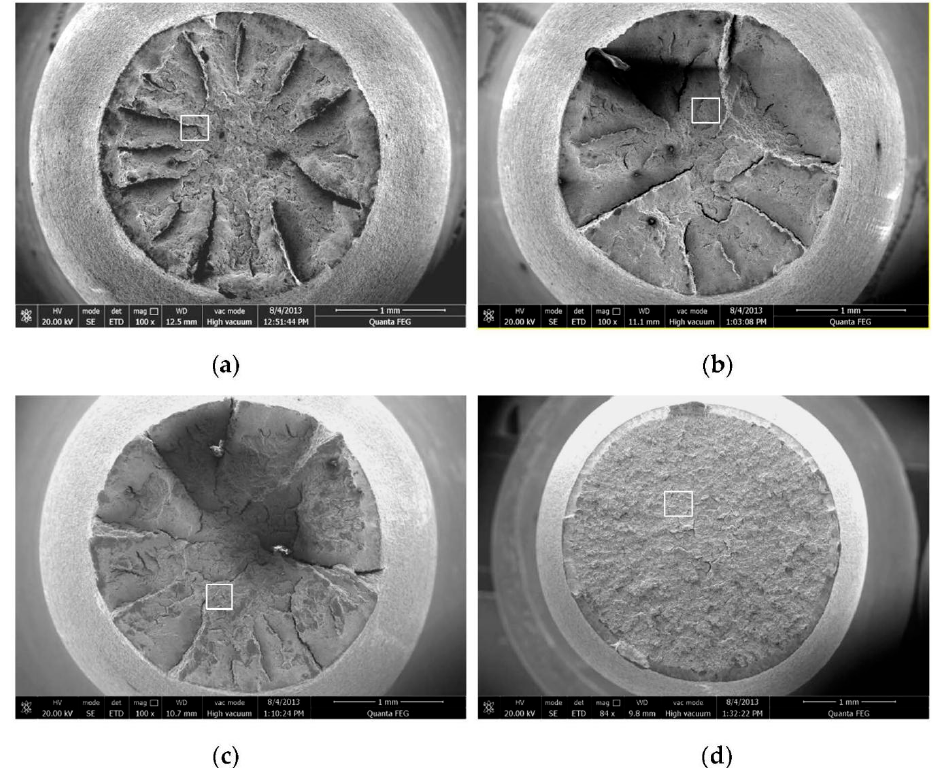
Figure 5. SEM images showing the macroscopic fractographs of samples tested at different temperatures: ( a ) − 80 °C, ( b ) − 120 °C, ( c ) − 160 °C, and ( d ) − 196 °C.